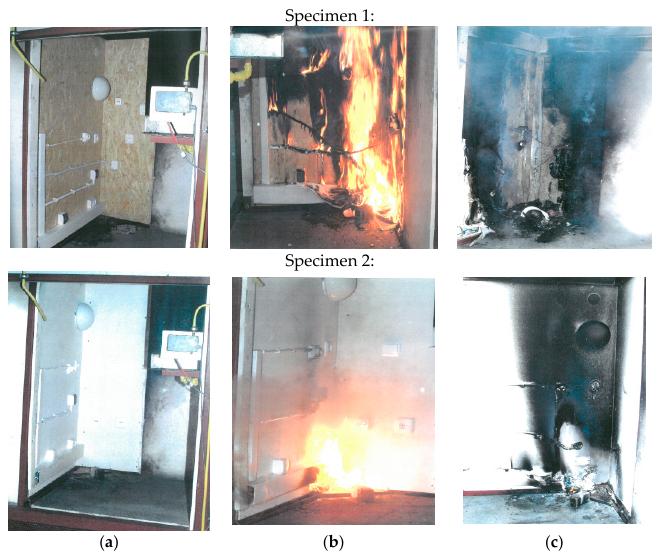
Figure 3. View of specimens at SBI test apparatus—electrical installation on the combustible substrate (specimen 1) and non-combustible substrate, e.g., calcium-silicate board (specimen 2): ( a ) before the test, ( b ) during the test, ( c ) after the test.